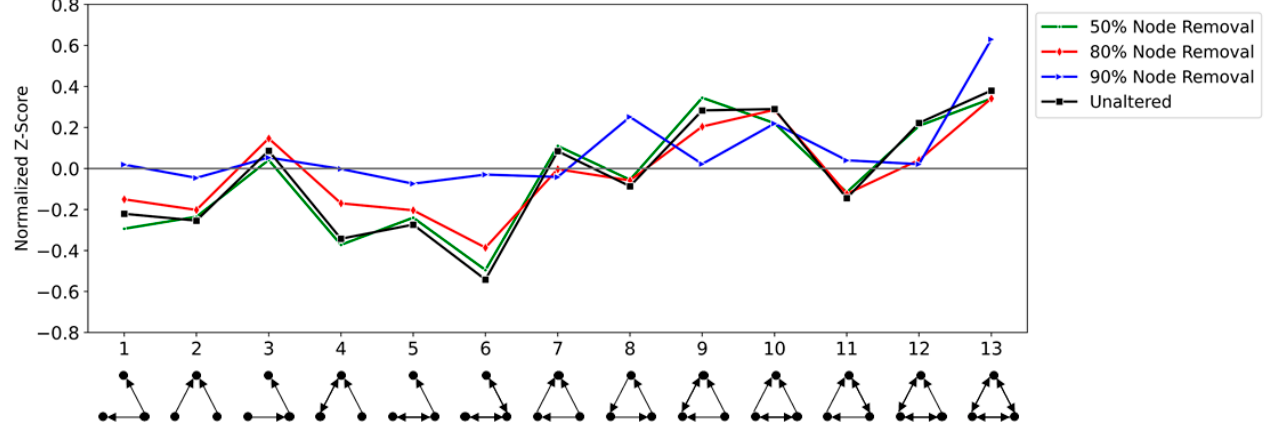
Figure 4. Robustness of aggregate energy trade network to disruption. TSPs of the aggregate energy network and of the same network after 50%, 80%, and 90% of nodes have been randomly removed. Each TSP is the average of 10 networks in which nodes have been randomly removed. Even after 80% of nodes have been removed, the correlation between the disrupted network’s TSP and the unaltered network is R = 0.96. Only after 90% of nodes have been removed is the TSP substantially altered (R = 0.53).